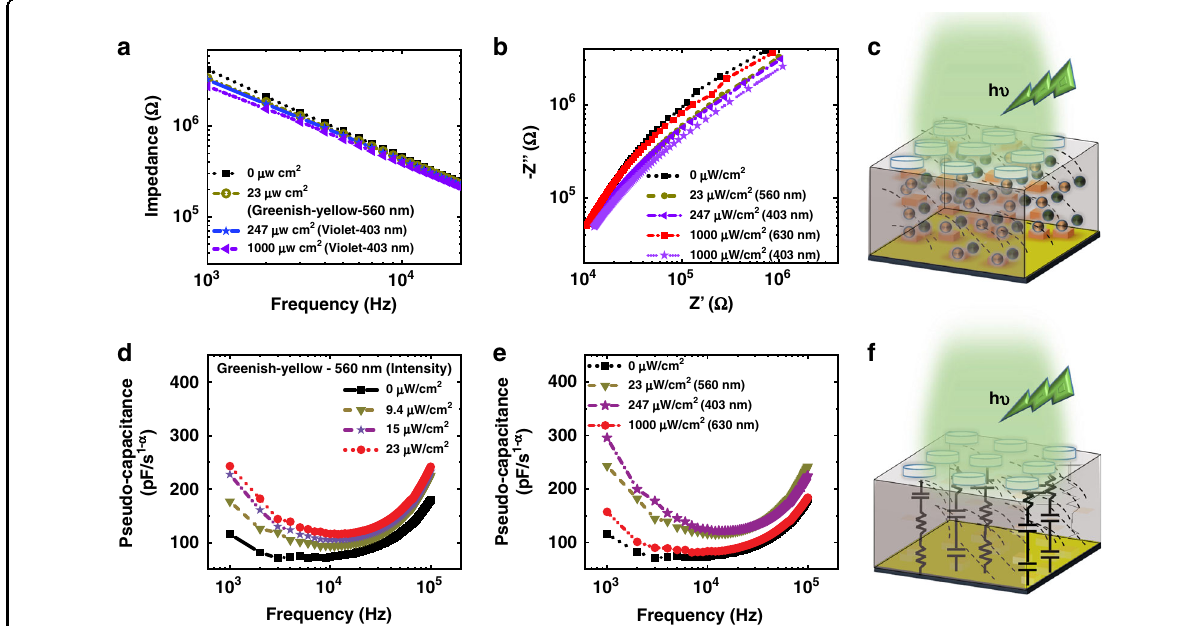
Fig. 3 The frequency-independent response of capacitive photoreceptors (CPRs). a The impedance of the CPRs corresponding to the change in light intensities of various LEDs. b The Nyquist impedance plot of CPRs indicating the frequency-independent behavior. c Schematic illustration of photo-generated carriers in PFNC. Pseudo-capacitance variation d under the illumination of greenish-yellow LED and e under various LEDs of different intensities. f Schematic illustration of varying dielectric properties in CPR, in fl uencing its fractional order impedance upon light